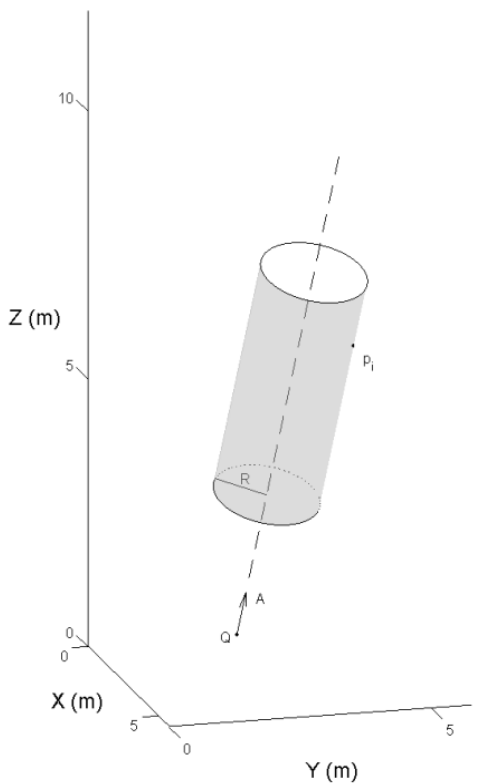
Figure 6. A cylinder and a point on its surface.